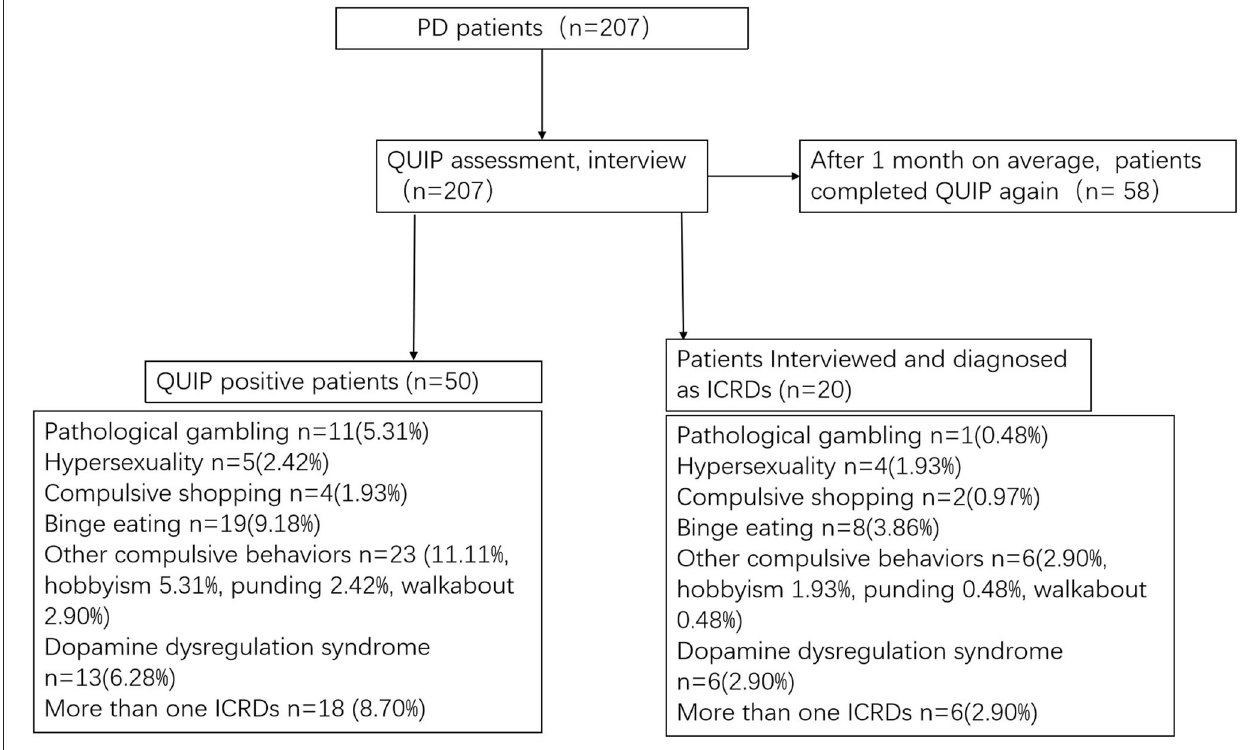
FIGURE 1 | Diagnostic flow chart for this